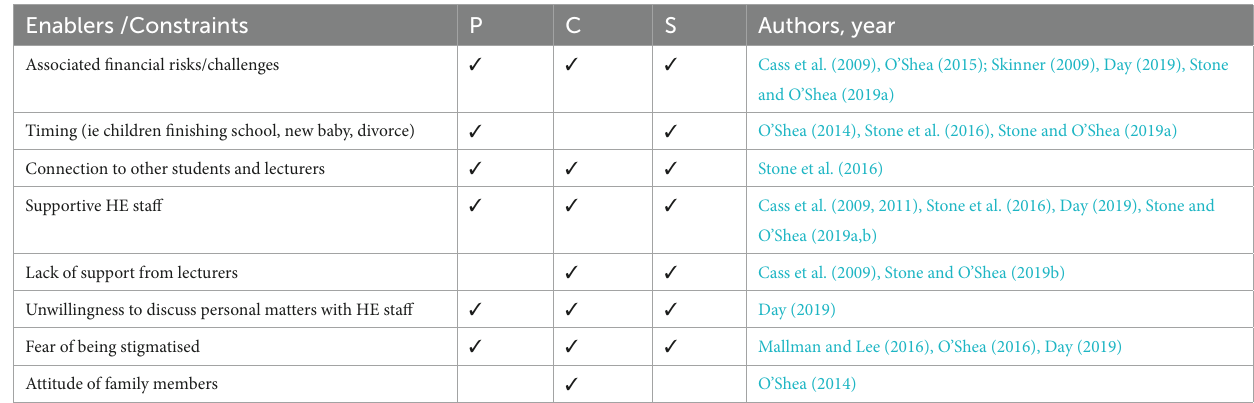
TABLE 6 Context sensitive enablers and